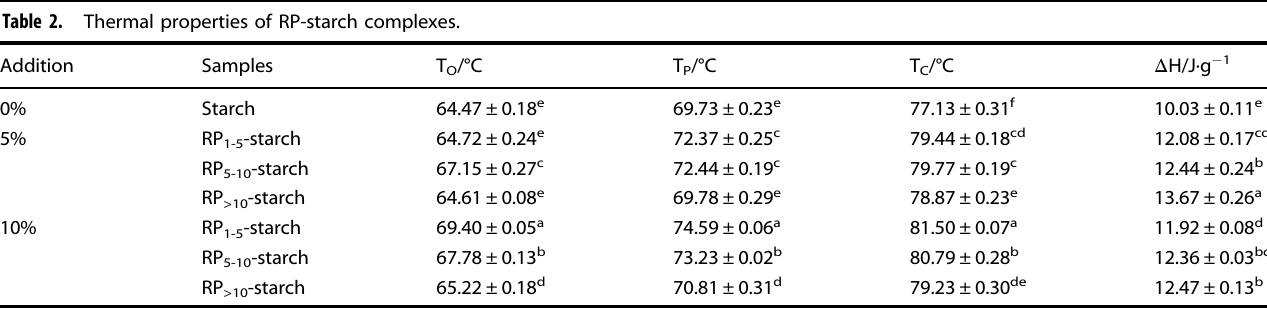
Each value is the mean of three replicates. For the same column, data with same letters do not differ signi fi cantly from each other whereas data with different superscripts differ signi fi cantly at the probability level p <0.05.